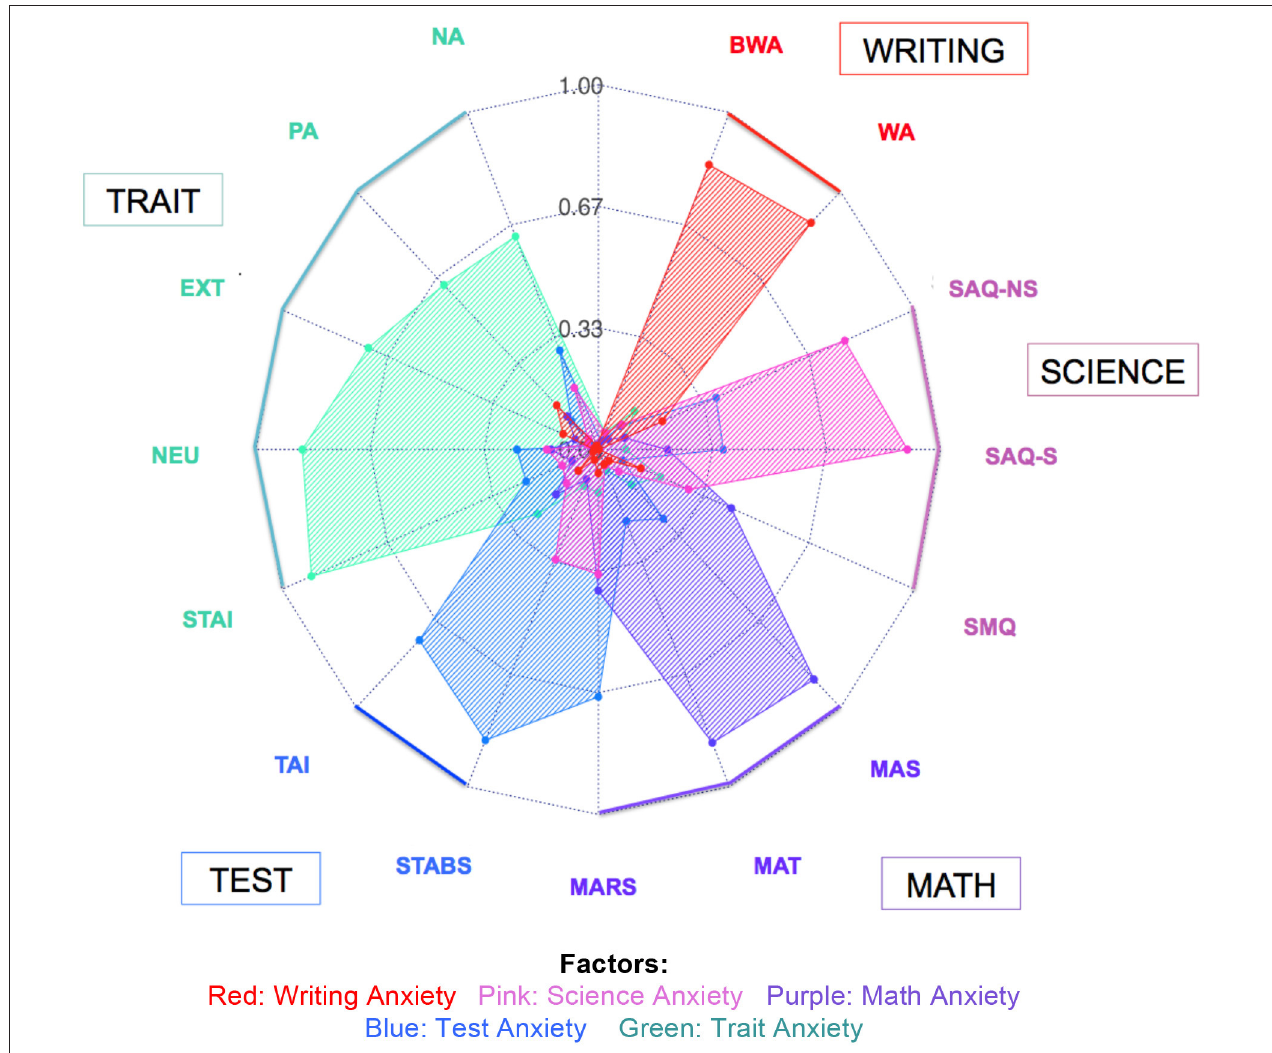
FIGURE 1 | Varimax-rotated factor analysis using single scales in Study 1. Factor scores for each factor are represented for writing, science, math, test, and trait anxiety in the main sample ( N = 285). Abbreviations for each scale are listed around the circle. For scale abbreviations, see Table 1 . Colors represent the hypothesized domains for each scale (e.g., the MARS is hypothesized to represent math anxiety, the TAI hypothesized to represent test anxiety). Values on the radar plot represent absolute values of the factor loadings for each scale. Zero is represented at the center of the plot, with increasing factor scores radiating out from the center. Values closer to the outside of the plot indicate higher factor